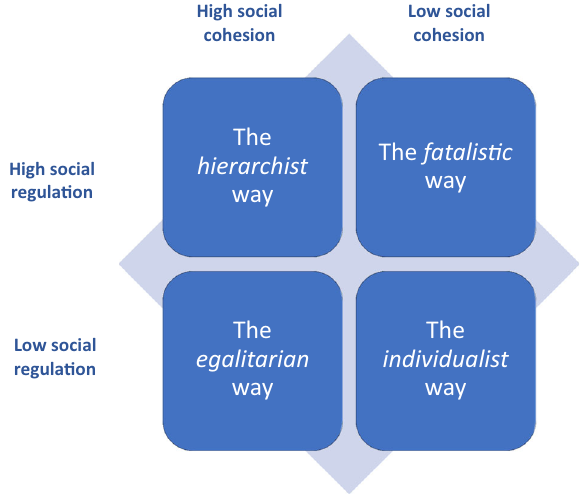
Fig. 1 The social cohesion/regulation matrix. This fi gure depicts a social cohesion/regulation matrix, which draws on the work of Hood